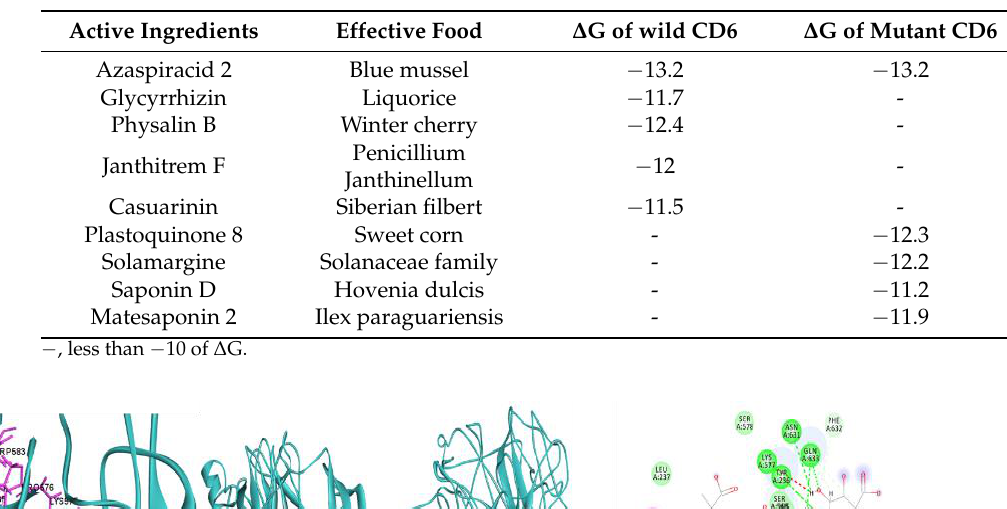
Table 5. Azaspiracid 2 showed low binding affinity ( − 13.2 kcal/mol) in both wild and mutated types of CD6 protein (Table 5). However, glycyrrhizin, physalin B, janthitrem F, and casuarinin lowered binding energy only in the wild CD6 protein but not in the mutated CD6 at R225W (Table 5). Plastoquinone 8, solamargine, saponin D, and matesaponin 2 decreased energy binding affinity in mutated CD6 proteins at R225W (Table 5). Glycyrrhizin decreased the energy for binding affinity ( − 11.7 kcal/mol) in wild CD6 proteins at R225W (rs11230563) but not the mutated one (Figure 4A–F). Table 5. The binding affinity of food compounds with wild and mutated CD6 proteins measured by free energy changes ( ∆ G; kcal/mol).